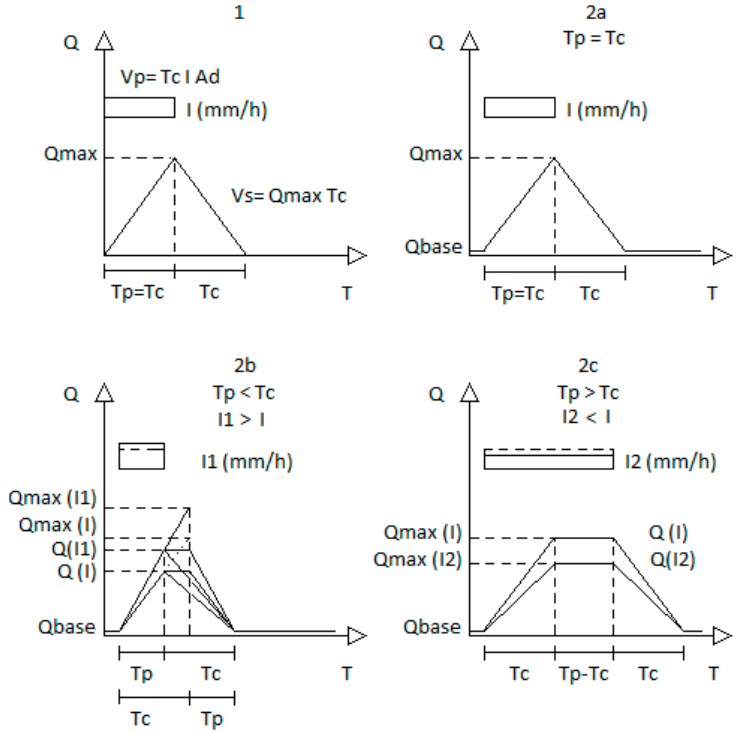
Figure 2. Classicrationalformulationandsimplifiedentrancehydrographsinurbanstormwaternetworks. Figure 2. Classic rational formulation and simplified entrance hydrographs in urban stormwater (A constant minimum / residual volumetric flow rate, Qbase, is assumed in all entrance networks. (A constant minimum/residual volumetric flow rate, Qbase, is assumed in all entrance hydrographs).